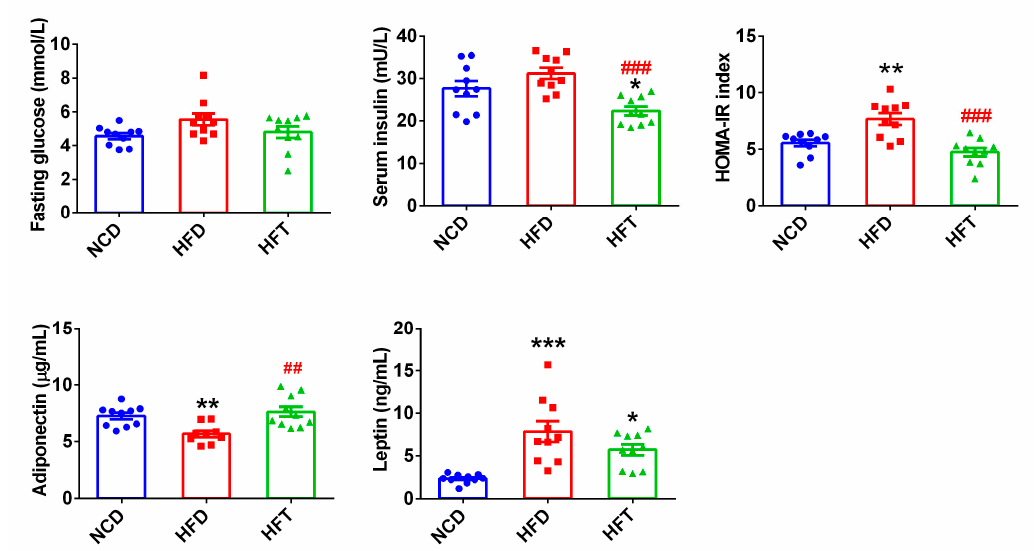
Figure 3. Administration of T17 attenuated insulin resistance and modulated adipokines. Data are expressed as mean ± SEM. Values marked with * are significantly different compared with NCD group and values marked with # are significantly different compared wih HFD group (* p < 0.05, ** or ## p < 0.01, *** or ### p < 0.001).